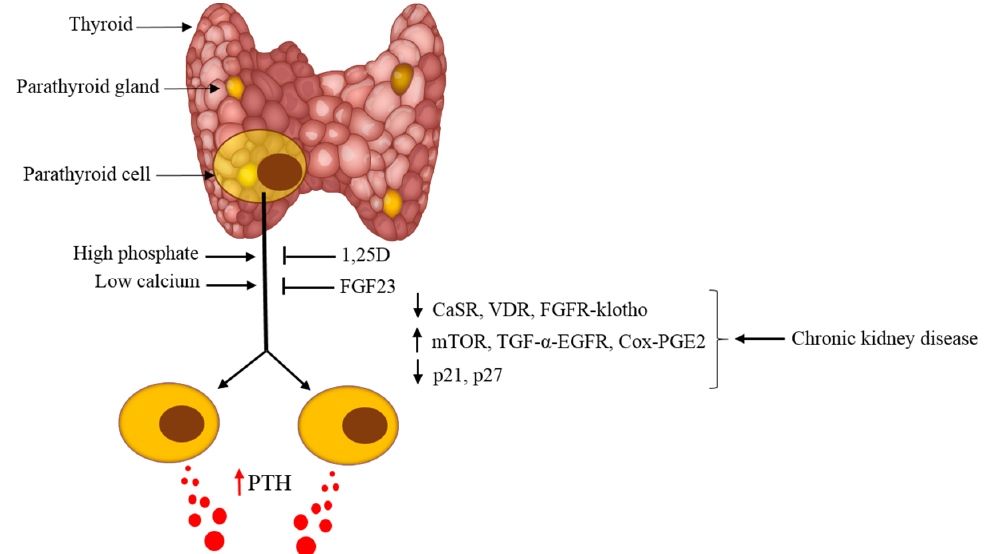
Figure 5. Regulators of parathyroid cell proliferation in SHP: Hyperphosphatemia and hypocalcemia stimulate and 1,25D and FGF23, inhibit PTH production and parathyroid cell proliferation. In CKD-induced SHP, decreased expression of the CaSR, VDR, and FGFR-klotho receptors together with activation of mTOR, TGF- α -EGFR, and cyclooxygenase 2- prostaglandin E2 (Cox-PGE2) signaling and changes in cell-cycle regulators lead to hyperplastic parathyroid glands with high serum PTH levels. miRNAs are essential for the development of SHP, but the identity of specific miRNAs remains to be determined (not shown). Manipulation of the above pathways may identify new targets to control SHP in CKD.